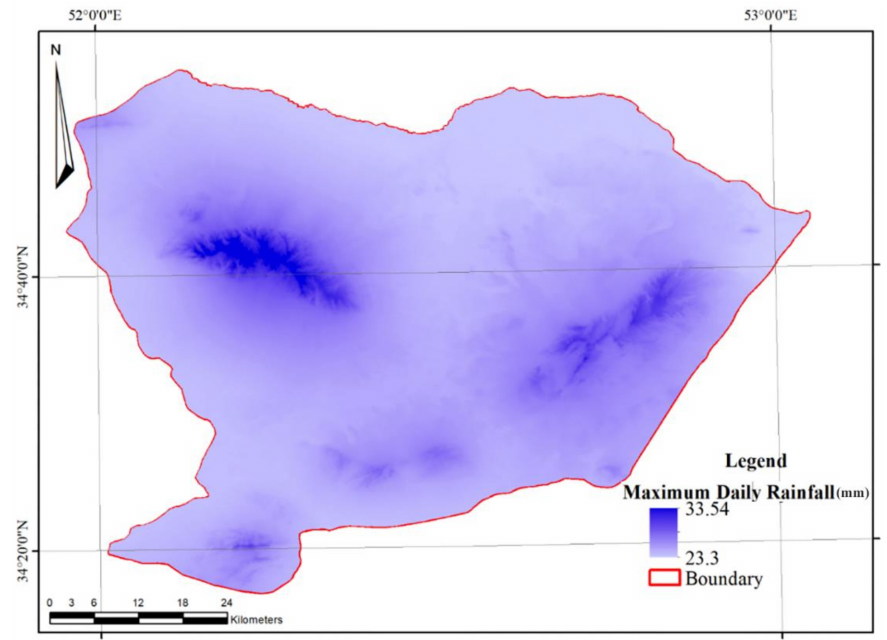
Figure 4. Map showing the 33% exceedance probability of maximum daily rainfall over the study area.